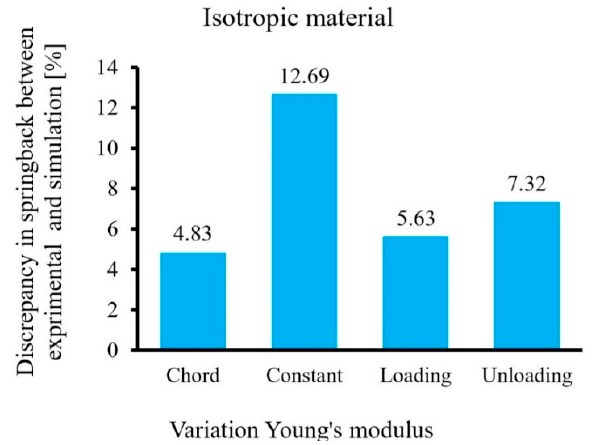
Figure 12. Discrepancy between the numerical prediction of springback (using various approaches to consider the evolution of elastic modulus) and the experimental data with isotropic hardening for the roll forming process.